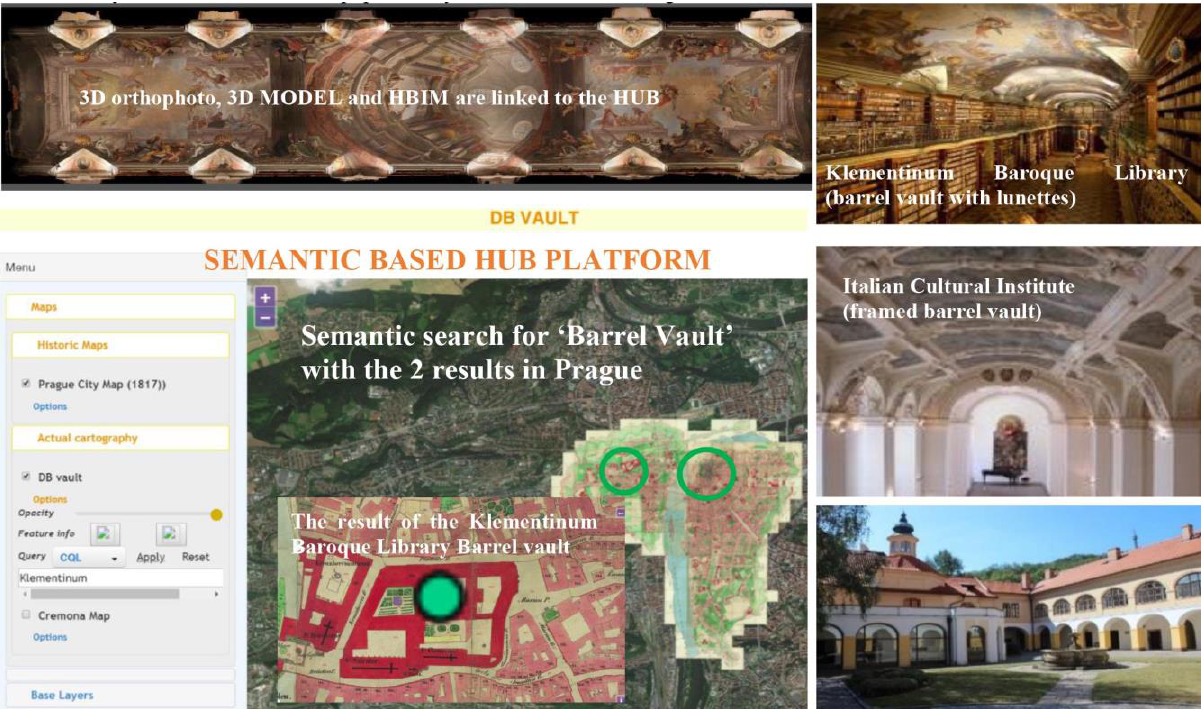
Figure 4. Semantic based hub platform and a query example across EU. On the 3 vaults inserted in the DB coming from the Pargue area, just 2 of them belongs to the Typology ‘Barrel vault’, the Klementinum Baroque Library, probably with arches, and the Italian Cultural Institute with the framed vault as resulted from the extrados surveying.